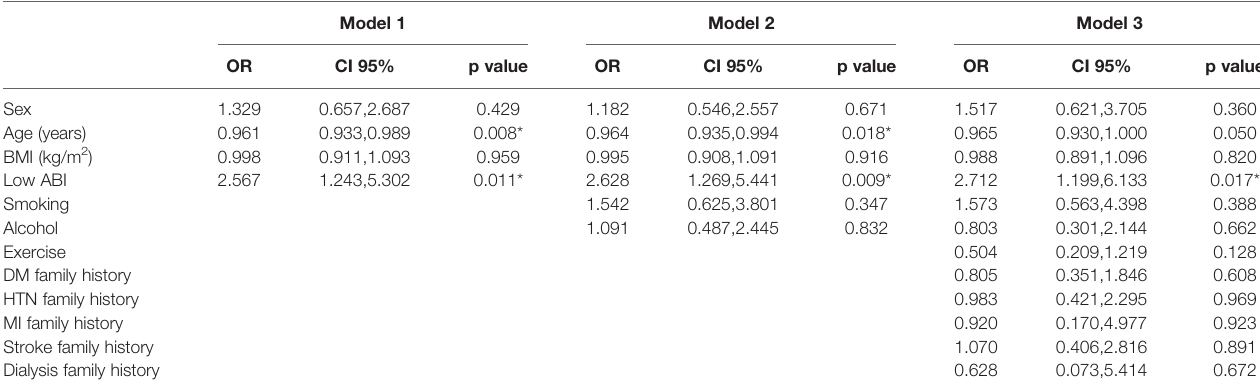
TABLE 4 | Odds ratios (OR) for foot ulcer by logistic regression with multivariable models.